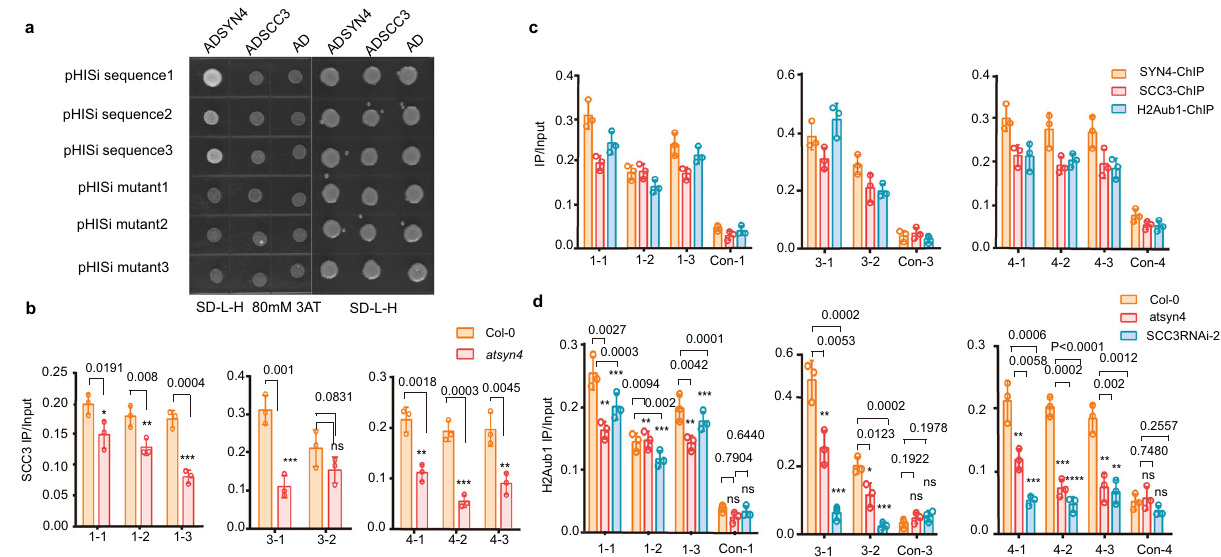
Fig. 6 | AtSYN4canbind the G-box-containing DNA directly. a Yeast one-hybrid assay shows that AtSYN4, but not AtSCC3, binds to the G-box motif-containing DNA. Sequence 1, sequence 2, and sequence 3 were 50bp G-box (CACGTG) con- taining DNA selected from the promoter regions of AT1G64385 (chr1:23,899,109 – 23,899,158), AT3G23440 (chr3: 8,404,698 – 8,404,747), and AT4G16380 (chr4: 9,254,461 – 9,254,510), respectively. Mutant 1, mutant 2, and mutant3werecorrespondingsequenceswithCACGTGmutatedintoGGGGGGand usedasthecontrol.Yeasttransformantsweregrownonsyntheticdropout(SD-Leu- His) plates with 3-AT (80mM) for 4 days. b ChIP-qPCRs show that AtSCC3 occu- pancyon DNA wasseverely reducedin atsyn4 mutant.Data are mean±SDof three